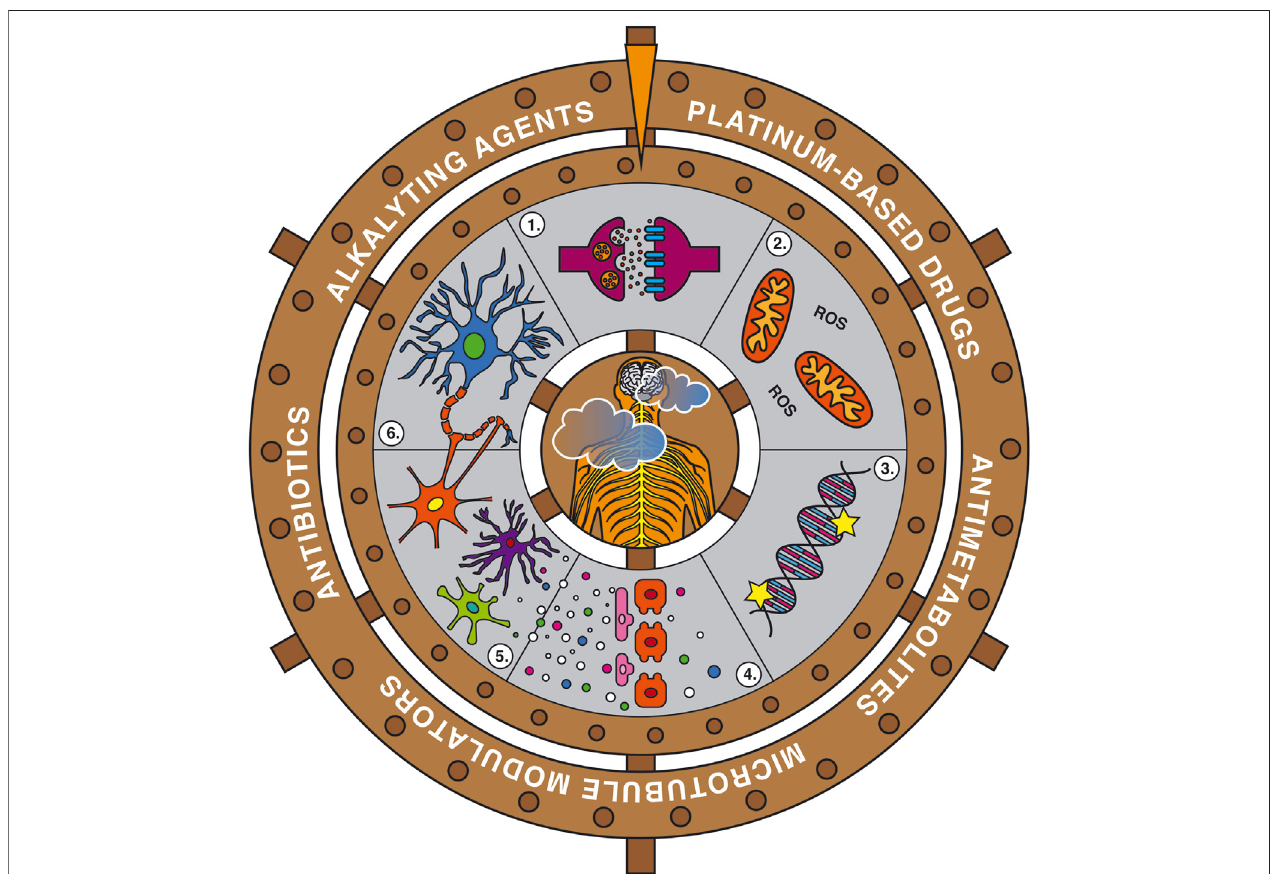
FIGURE3| Peripheralandcentral neurotoxicity-awheelofbadfortune.InRomanmythology,Fortunaisthegoddess, whodirectshumanfateasthedeityofboth happiness and misfortune. In the art, Fortuna was depicted sitting or standing with a cornucopia and often blindfolded. On the reverse of Roman coins, she is usually shown withawheel ather side.Wepropose toconsiderchemotherapy-inducedneurotoxicity(peripheral neuropathy, chemobrain) asawheel ofbad fortune. Nomatter what chemotherapeutics drugs are used: alkylating agents, platinum-based drugs, antimetabolites, microtubule modulators or antibiotics and what biological mechanismstheytrigger:1.downregulatedneurotransmitters ’ secretion,2.overproductionofreactiveoxygenspecies,3.geneticalterations,4.neuro-in fl ammationand breakdown of the blood-brain barrier, 5. reduced gliogenesis and hyperactivation of microglia and astrocytes, 6. impairment in neurogenesis and neural network dynamics, this will lead to the development of nervous dysfunctions (neuropathic pain, cognitive de fi cits) in the majority of cancer patients.